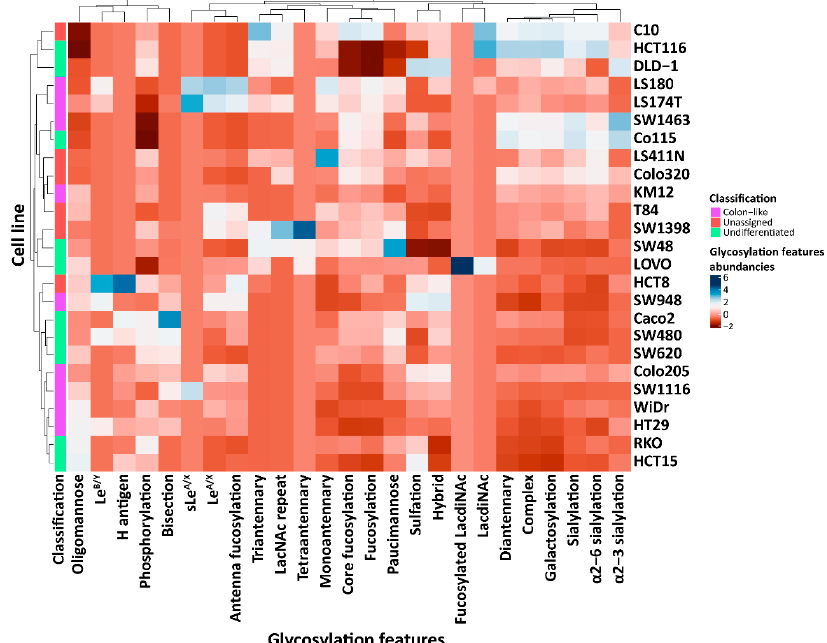
Figure 2. Distribution of N -glycosylation features in 25 CRC cell lines. The relative quantification of each glycosylation feature (bottom) was calculated for each cell line (right) and displayed in a clustered heatmap. The classification of the CRC cell lines is marked using color codes.